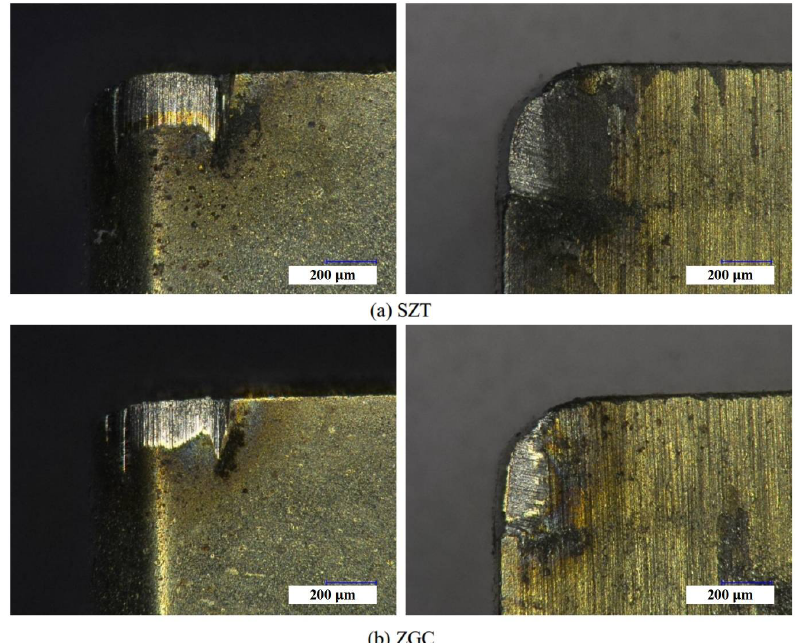
Figure 13. Micrographs of the worn flank face and rake face ( v = 120 m/min, a p = 0.20 mm, f = 0.10 mm/r, L = 3600 m).